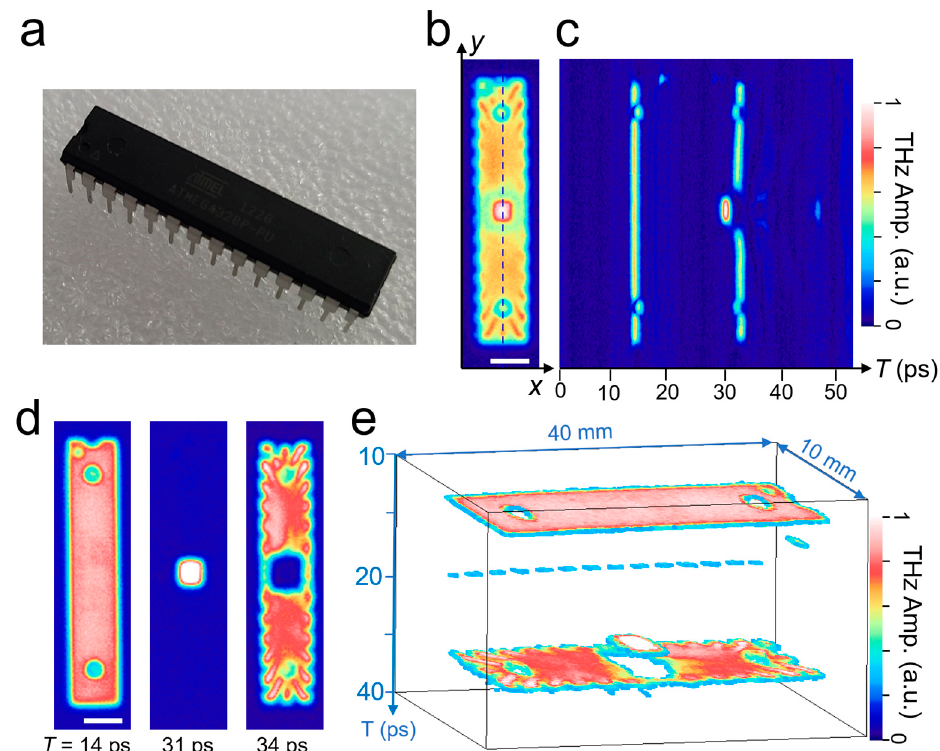
Figure 5. ( a ) Photograph of the chip with dimensions of 8 mm × 35 mm × 3.3 mm. ( b ) Time-integrated C-scan envelopes for the packaged device. ( c ) B-scan images along the dashed line in ( b ). Scale bar = 5 mm. ( d ) A series of C-scan ( xy ) images for T = 14, 31, and 34 ps, respectively. ( e ) Reconstructed 3D image for the device.